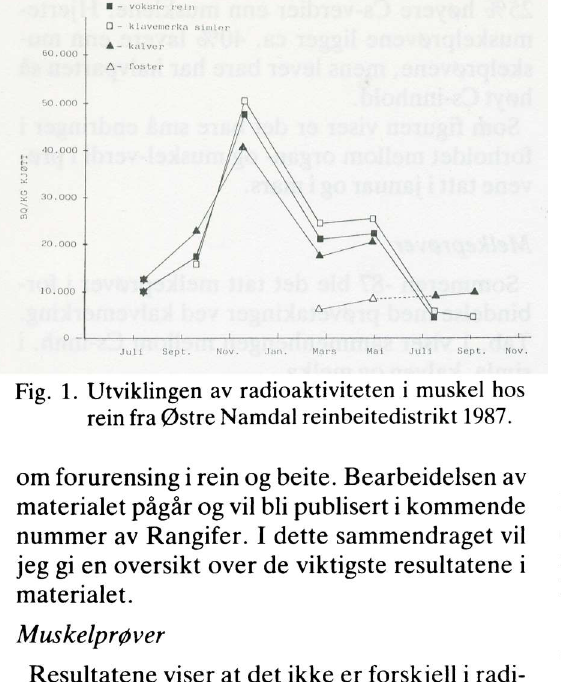
Fig. 1. Utviklingen av radioaktiviteten i muskel hos rein fra Østre Namdal reinbeitedistrikt 1987.